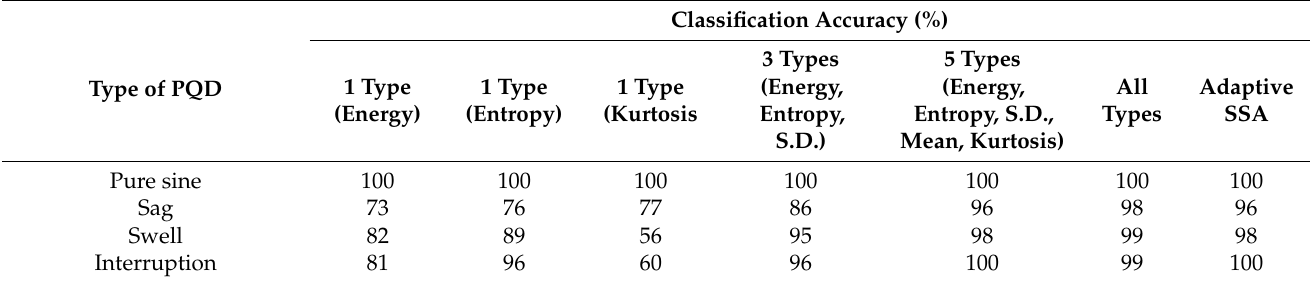
Table 6. Classification accuracy using different statistical